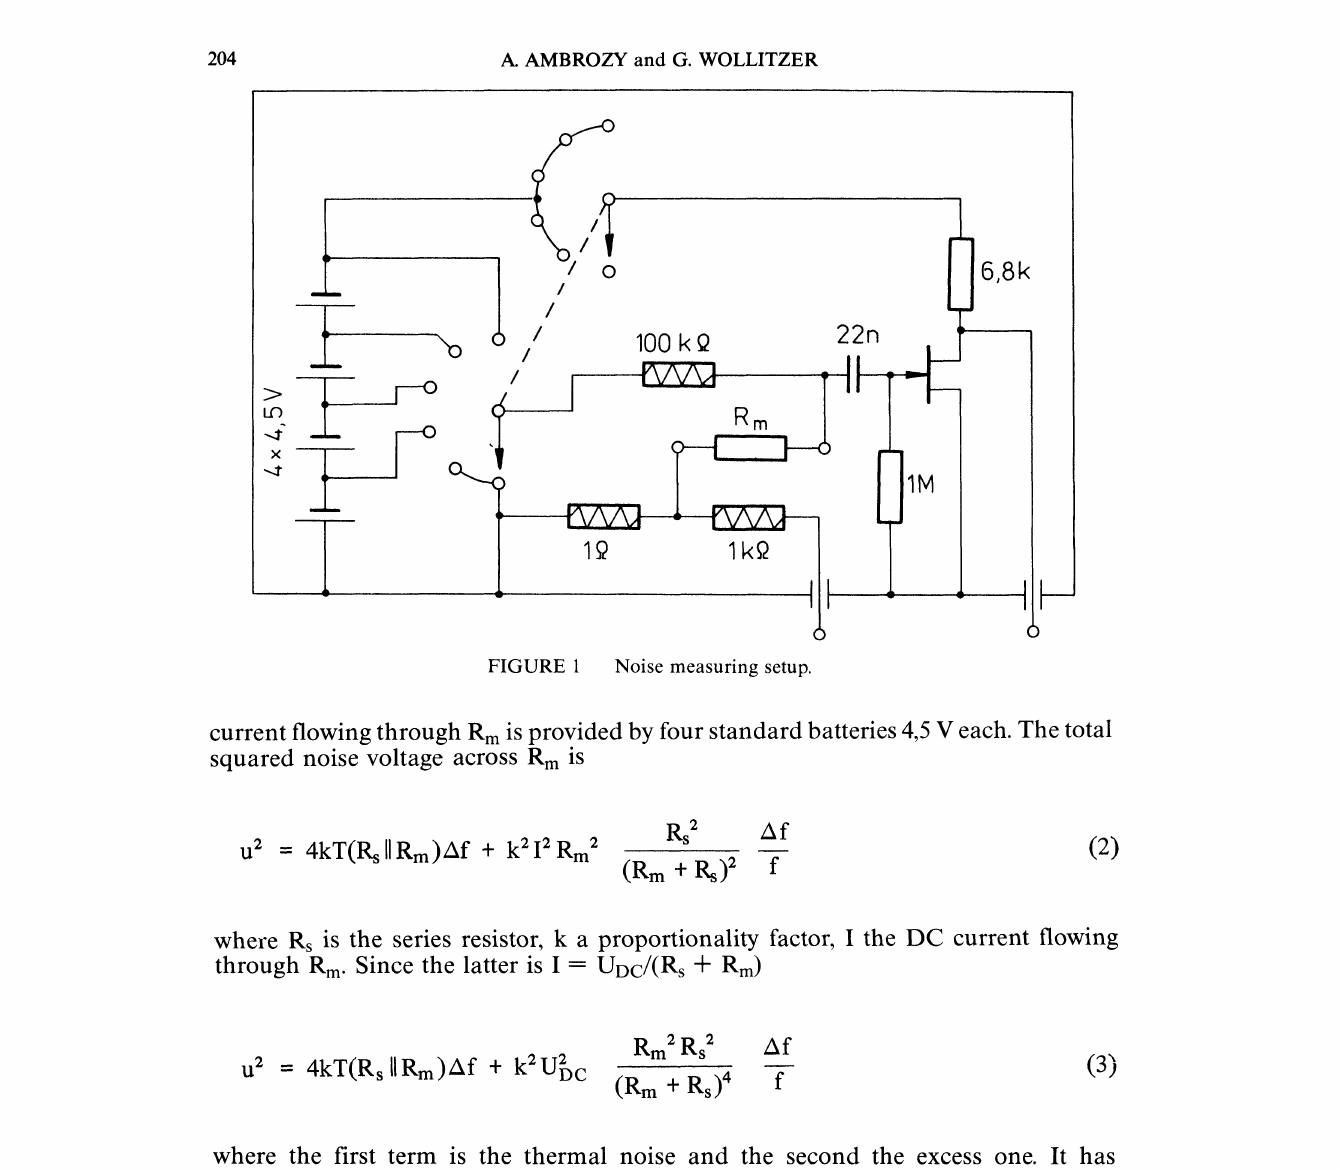
FIGURE Noise measuring